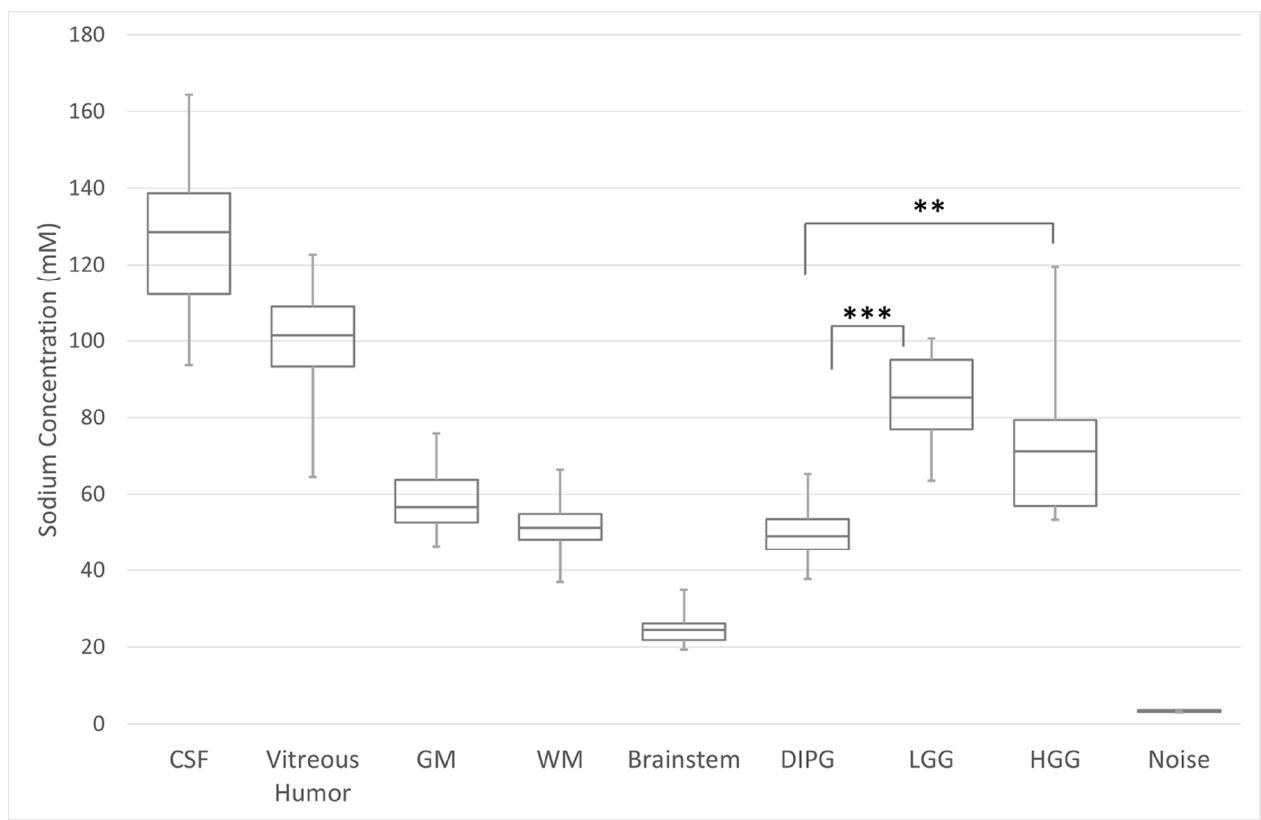
Figure 1. Total sodium concentration (TSC) of the uninvolved cerebral tissue, vitreous humor, and cerebrospinal fluid (CSF), against tumor type. T-test comparing tumor grade ** = p < 0.05; *** p < 0.001. GM = grey matter, WM = white matter, DIPG = diffuse infiltrating pontine glioma, LGG = low-grade glioma, HGG = high-grade glioma.